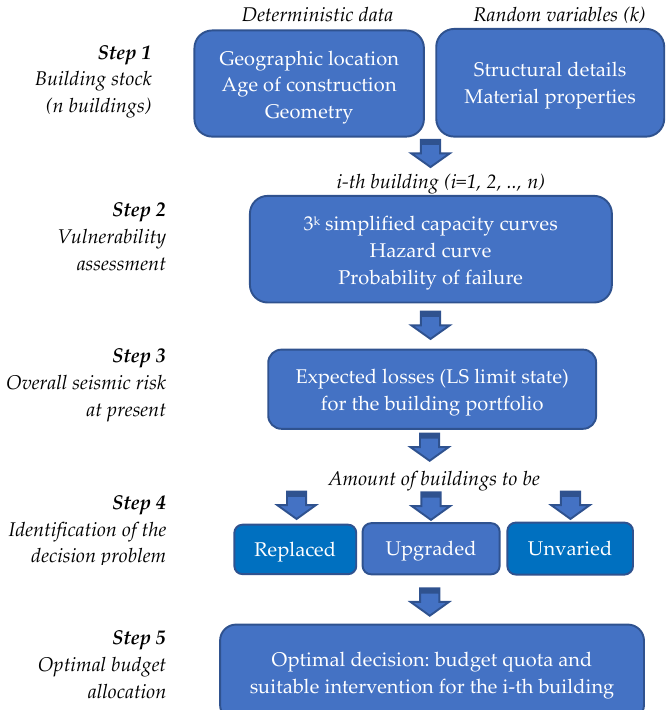
Figure 1. Flowchart of the simplified procedure for regional seismic risk assessment and mitiga- tion.